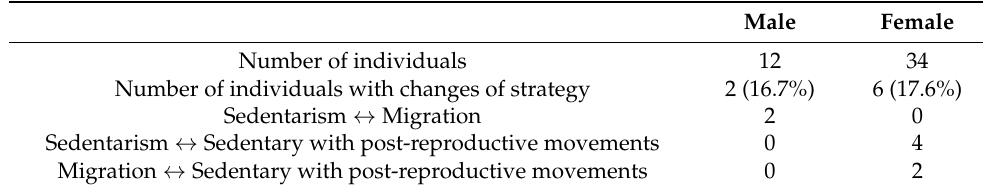
Table 3. Strategy changes in the individuals between post-reproductive periods. “ ↔ ” indicates at least one change in the individual from one strategy to another, or vice versa. Male Female Number of individuals 12 34 Number of individuals with changes of strategy 2 (16.7%) 6 (17.6%) Sedentarism ↔ Migration 2 0 Sedentarism ↔ Sedentary with post-reproductive movements 0